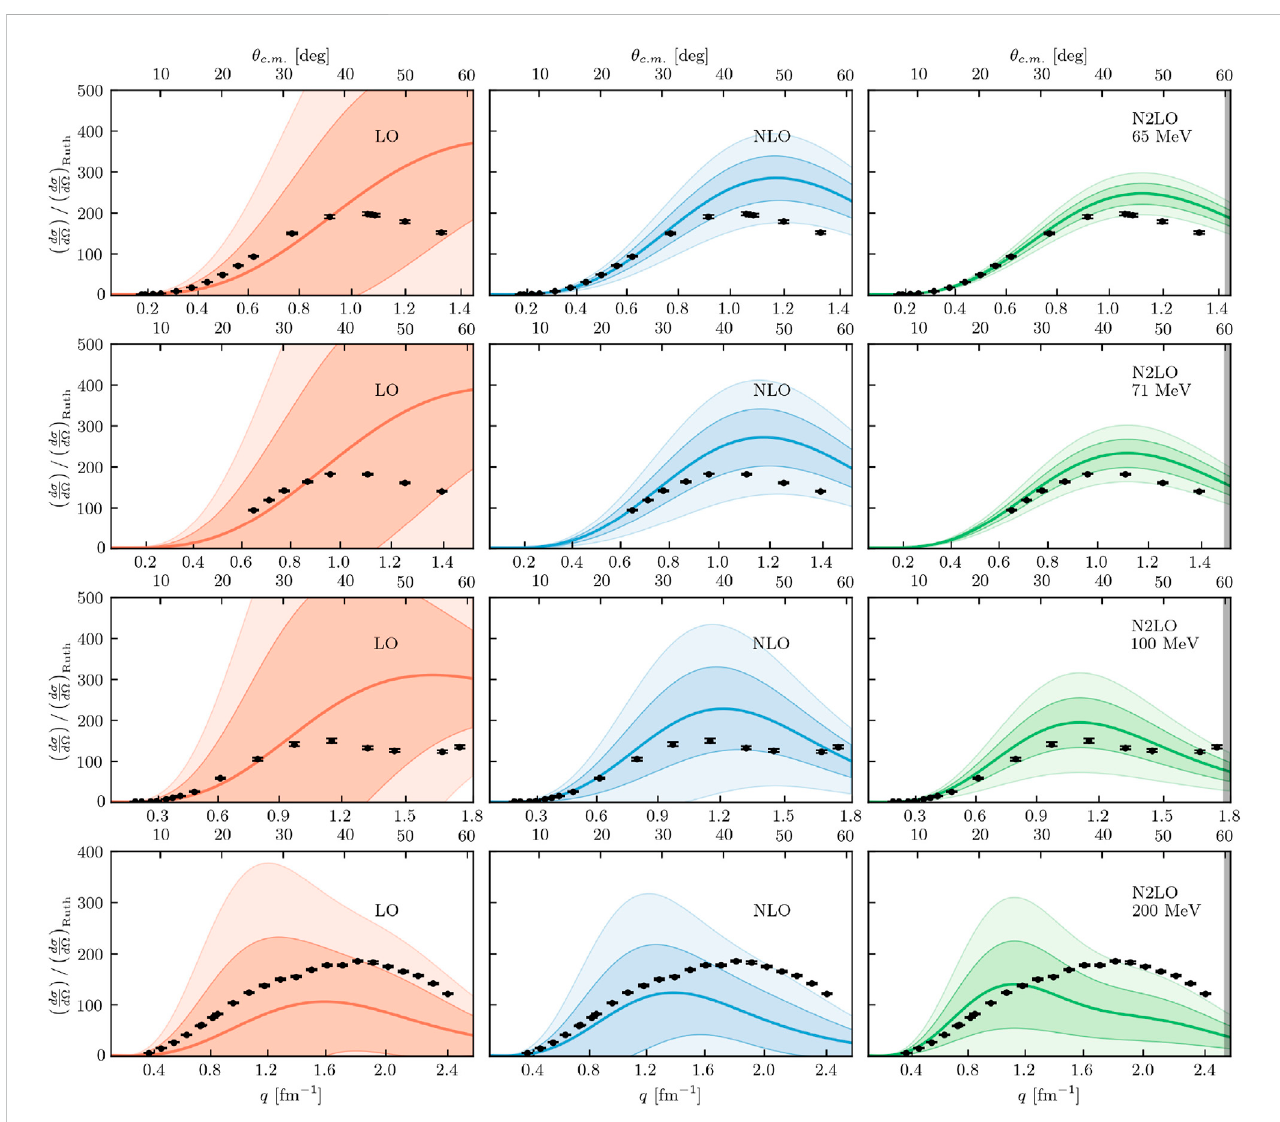
FIGURE 4 Differential cross section divided by Rutherford for proton scattering on 4 He at( fi rst row) 65 MeV, (second row) 71 MeV, (third row) 100 MeV,and (fourth row) 200 MeV for LO (left column), NLO (middle column), and N2LO (right column) with corresponding 1 σ (darker bands) and 2 σ (lighter bands) error bands. Black dots are experimental data from Ref. [75] (65 MeV) [76], (71 MeV) [77], (100 MeV), and [78] (200